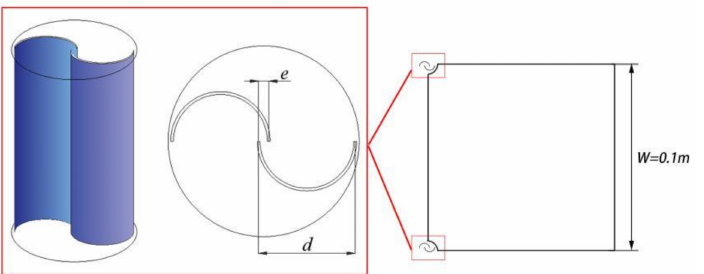
Figure 2. Sketch of Savonius wind turbines.